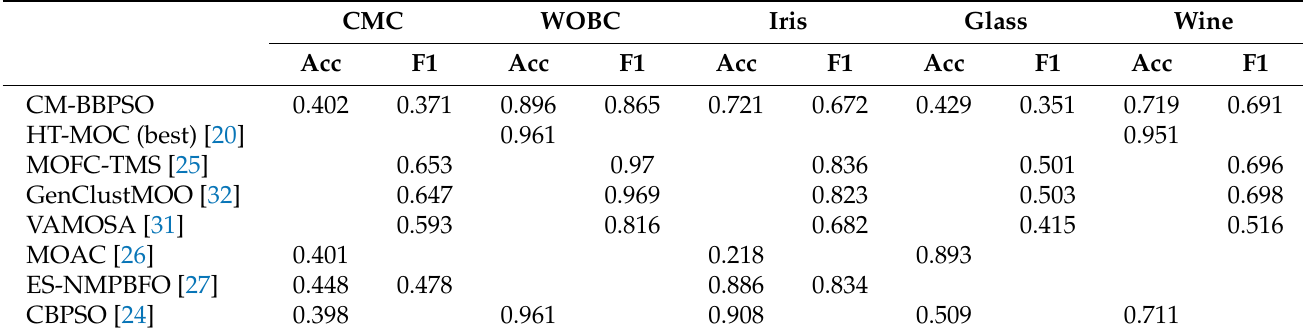
Table 8. Comparison of CM-BBPSO with other reported cluster-based MOC, MOC and BBPSO clustering algorithms. CMC WOBC